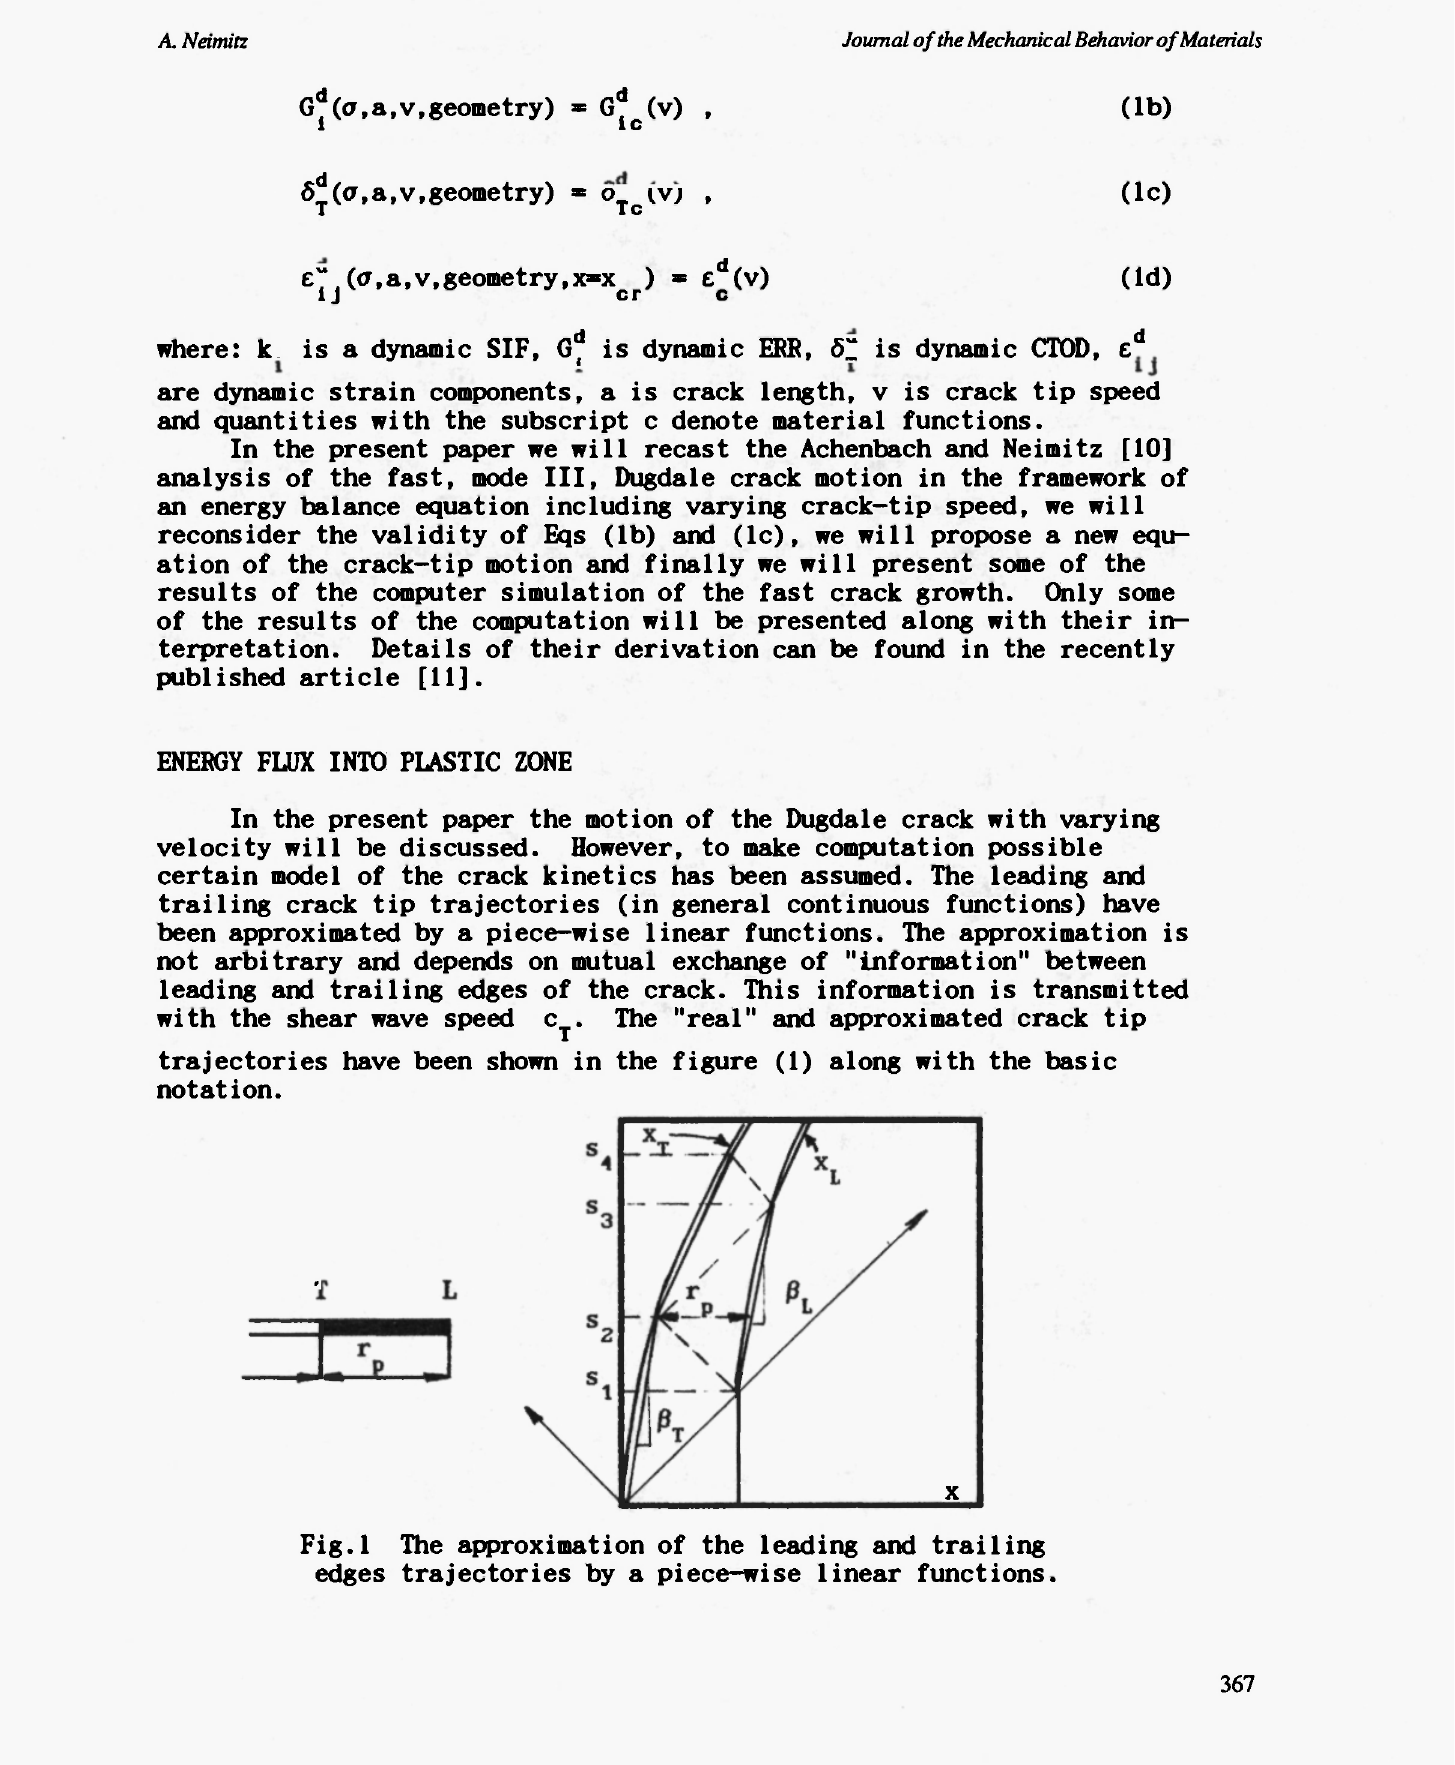
Fig.l The approximation of the leading and trailing edges trajectories by a piece-wise linear